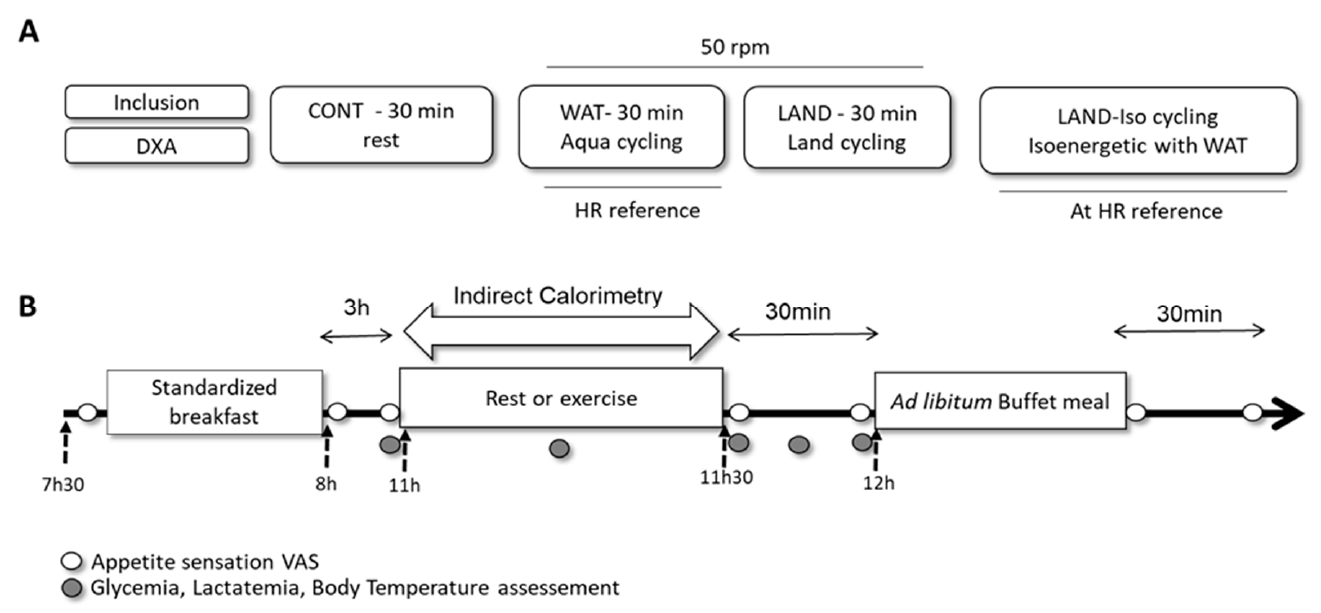
Figure 1. Schematic representation of the study design ( A ), and of experimental session ( B ). DXA: Dual X-ray Absorptiometry; CONT: control session; WAT: Water cycling session; LAND: Land cycling session.